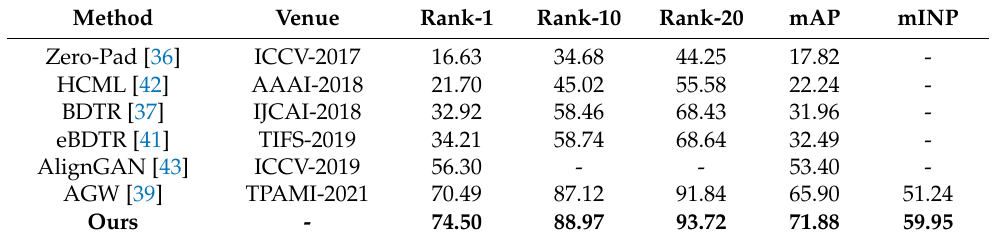
Table 4. Comparison results in I2V mode for Table 3. Comparison results in V2I mode for RegDB.